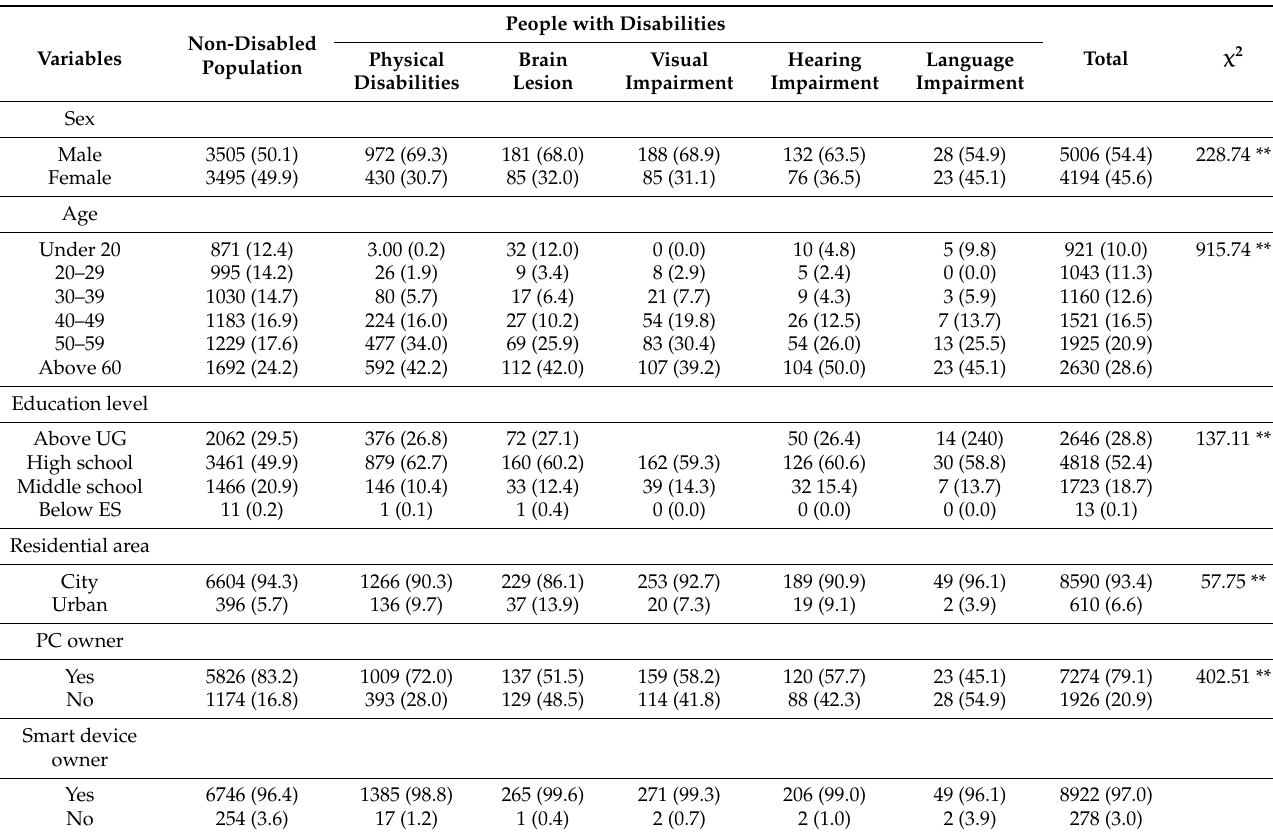
Table 1. General